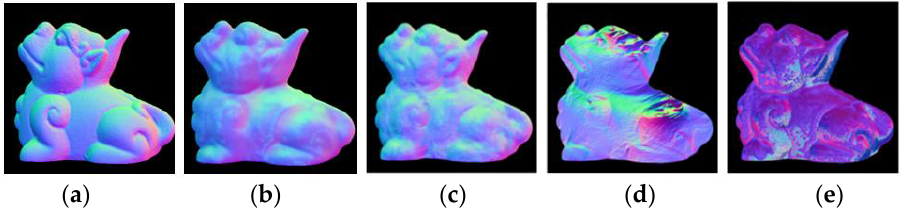
Figure 13. Comparison of neural network estimation normal vector algorithms. ( a ) True; ( b ) Ours;